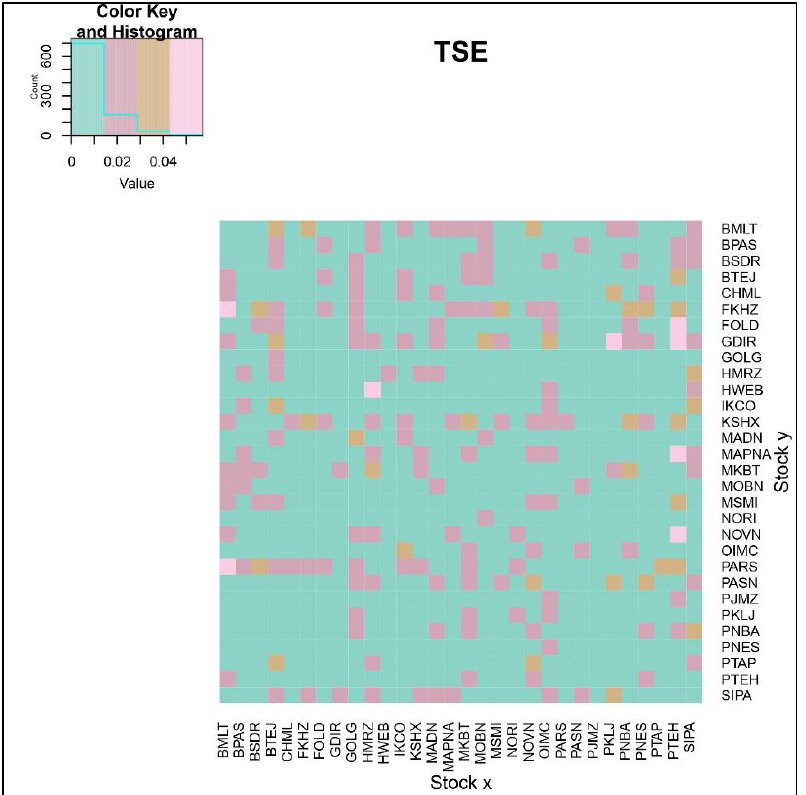
Figure 26. The information flow (effective transfer entropy) from stock y to stock x, for the top companies (by market capitalization) in the TSE market, after the COVID-19